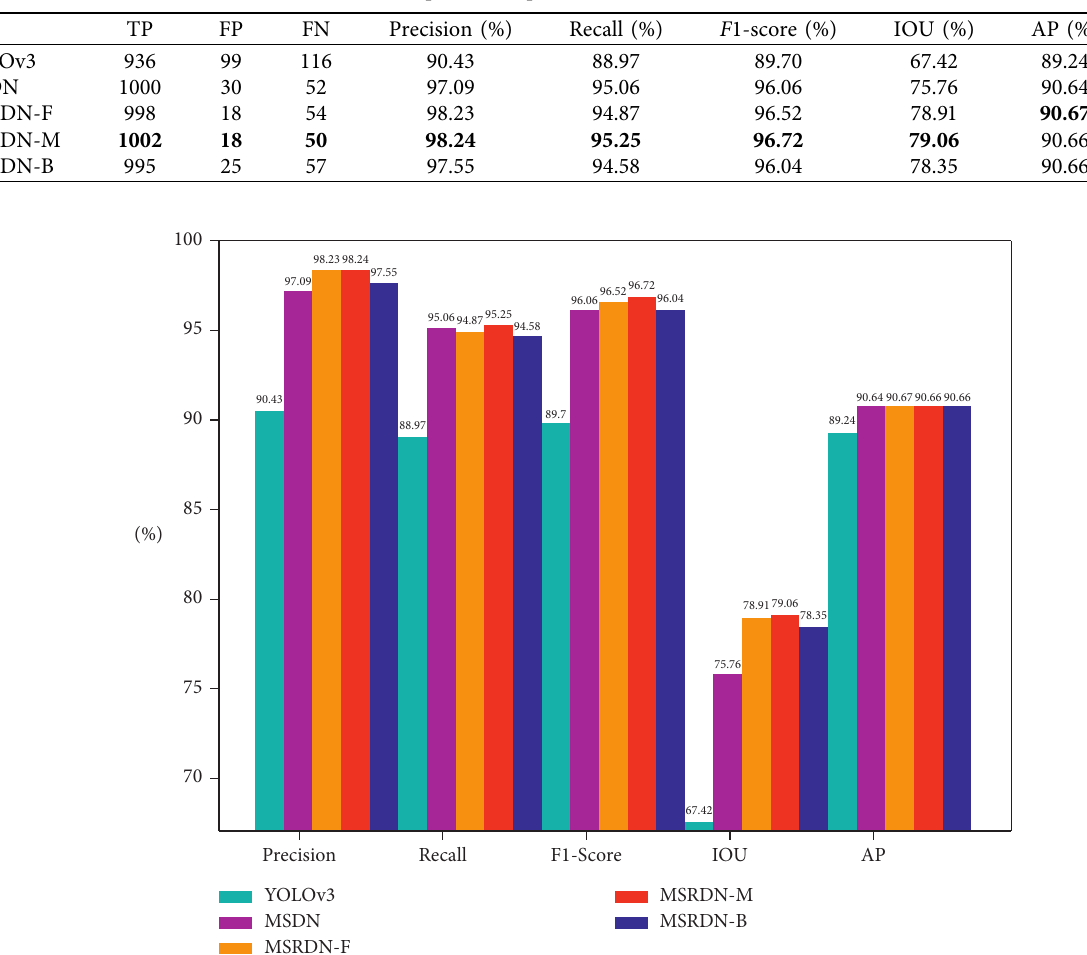
Figure 15: The comparison of precision-recall curves. Table 2: The comparison of performance indicators for the aircraft.